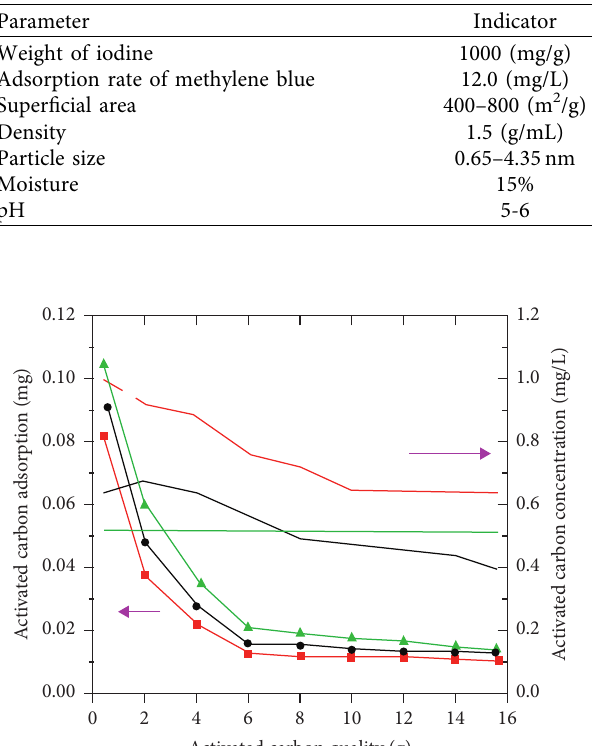
Table 1: Main activities of fruit-peel activated carbon.